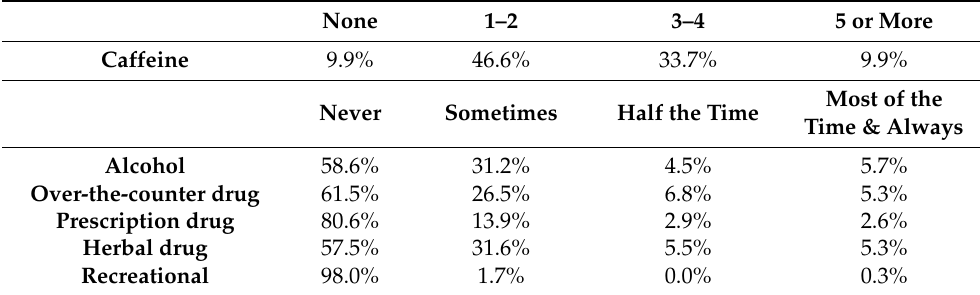
Table 4. Frequency of daily caffeine intake and use of alcohol and drugs to facilitate sleep (Total n =